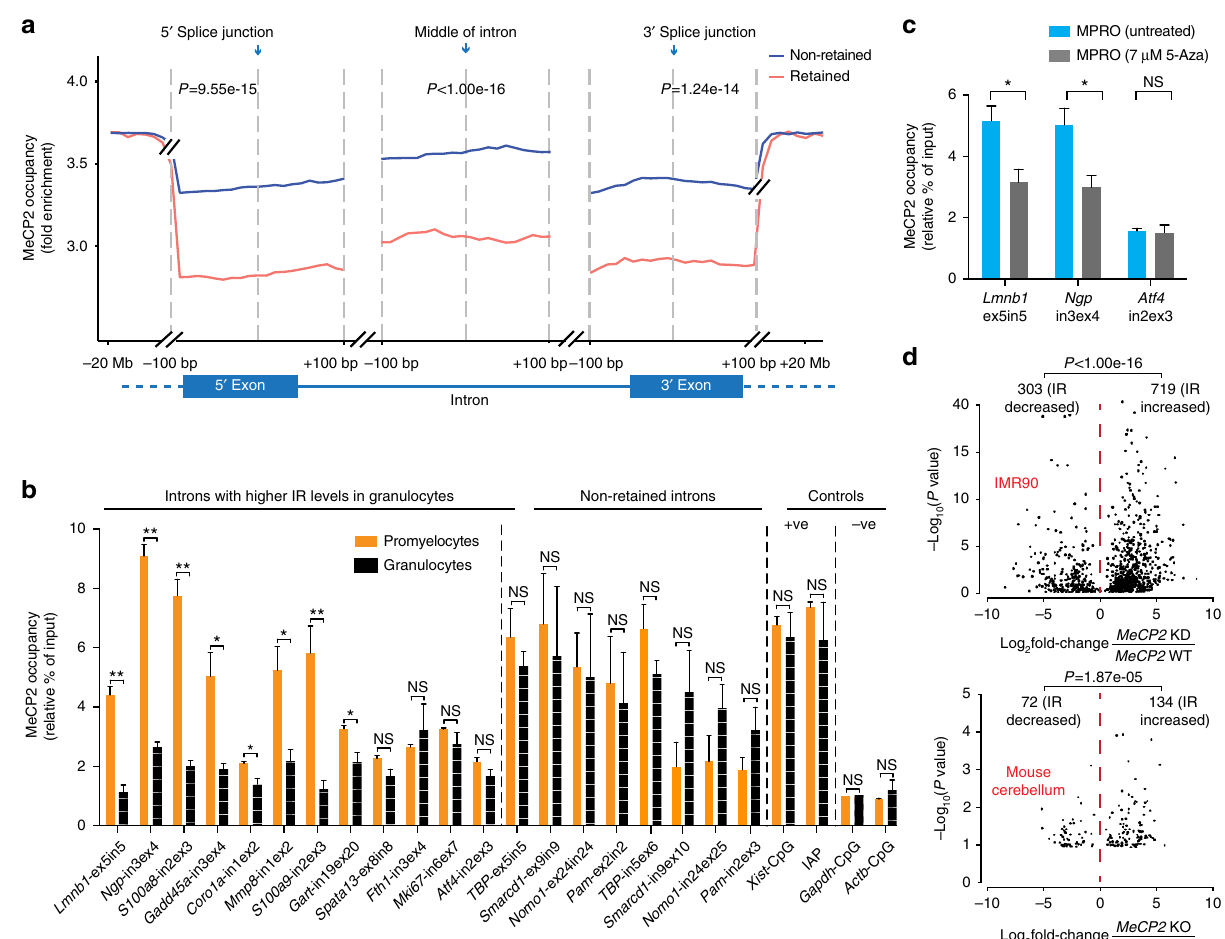
Figure 3 | IR is associated with reduced MeCP2 binding near splice junctions. ( a ) Average MeCP2 occupancy normalized against input as measured by ChIP-seq in promyelocytes and granulocytes combined. MeCP2 occupancy is displayed for regions spanning ± 100bp from the 5 0 and 3 0 splice junctions, and the middle of introns, in the DNA encoding non-retained (blue) and retained introns (red). Data were extended to (cid:2) 20Mb and þ 20Mb from the 5 0 and 3 0 splice junction respectively. t -tests were used to determine significance at P o 0.05. ( b ) Occupancy of MeCP2 near splice junctions of the DNA encoding introns with increased IR in granulocytes and controls measured by ChIP-qPCR. ( c ) ChIP-qPCR-measured occupancy of MeCP2 near splice junctions of the DNA encoding differentially retained introns of Lmnb1 and Ngp pre- and post- 5-Aza-2 0 deoxycytidine treatment (5-Aza) in MPRO cells. Atf4 intron 2 is included as a negative control. ( d ) Association between IR ratio fold changes and their significance following Mecp2 knockdown in IMR90 cells or Mecp2 - knockout in primary mouse cerebellum. Binomial test was used to determine the significance of bias between increased and decreased IR at P o 0.05. For each ChIP-qPCR experiment, a two-tailed Student’s t -test was used to determine significance, denoted by * P o 0.05, ** P o 0.001 and ns, not significant. Bars display mean ± s.e.m. Independent ChIP-qPCR experiments were performed three to five times in triplicate. Figure 2 | IR increases with reduced DNA methylation and increases following DNA methylation inhibition. ( a ) Average CpG methylation levels spanning ± 100bp from the 5 0 and 3 0 splice junctions in the DNA encoding non-retained (blue) and retained (red) introns in primary mouse fibroblasts, mouse reprogrammed fibroblasts, human cell lines (H1, H9, HCT116 and IMR90) and primary human neuron progenitors. Data were extended to (cid:2) 20Mb and þ 20Mb from the 5 0 and 3 0 splice junctions, respectively. Paired t -tests were used to determine significance at P o 0.05. ( b ) Association between the IR ratio fold changes and their significance following double knockout of Dnmt3a and 3b in primary mouse B cells and HSCs. Binomial test was used to determine the significance of bias between increased and decreased IR at P o 0.05. ( c – f ) Upper panel: clonal bisulfite sequencing displaying DNA methylation changes near splice junctions of Lmnb1 intron 5, Ngp intron 3, Spata13 intron 8 and S100a8 intron 2 in MPRO cells following treatment with 3 or 7 m M 5-aza-2 0 deoxycytidine (5-Aza). Each row represents a single-cloned PCR amplicon aligned to the exon–intron map shown. Each lollipop on the map represents a CpG site. Black and white circles denote methylated and unmethylated CpGs respectively. Lower panel: IR levels determined by qRT-PCR for specific introns indicated in MPRO cells, with and without exposure to 5-Aza at 3 or 7 m M, and in the absence (–) or presence ( þ ) of NMD inhibition via caffeine (CAF) treatment. Two-tailed t -test was used to determine significance at P o 0.05. Bars display mean ± s.e.m. Independent qRT-PCR experiments were performed three times in triplicate ( n ¼ 3). NS, not significant; Avg. meth., average DNA methylation